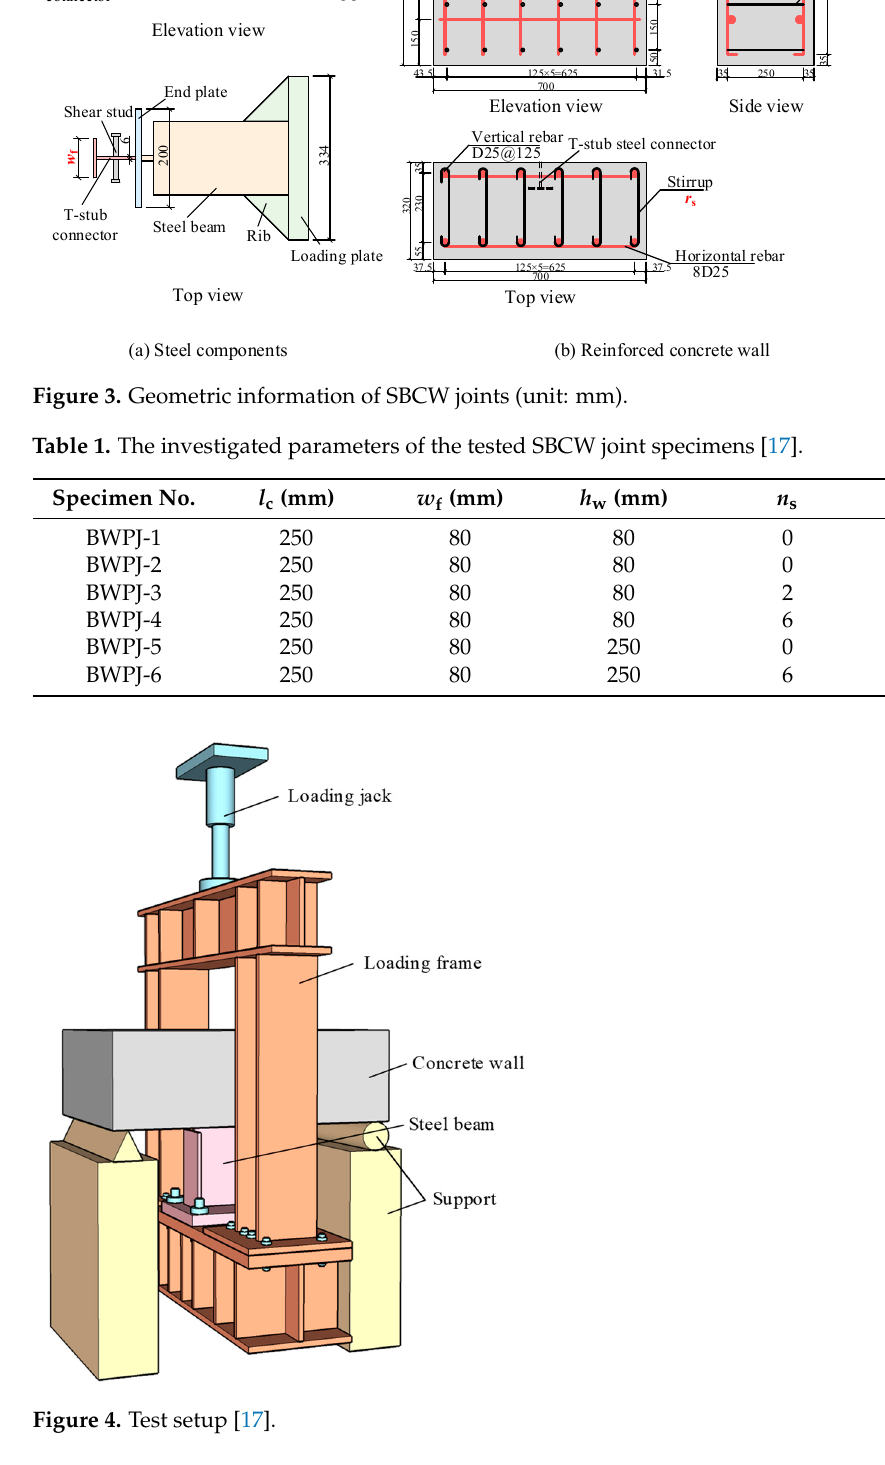
Figure 5. Numerical model of SBCW joints. The mesh size was determined based on an analysis of mesh sensitivity [21,22]. Fig ‐ ure 6a shows the load ‐ displacement curves of the numerical model of specimen BWPJ ‐ 1 with different mesh sizes. The comparison indicates that when the mesh size decreases to 20 mm, the effect of the mesh size can be ignored. Therefore, the mesh size of the main components including the T ‐ stub connector, end plate, concrete wall and reinforcements,